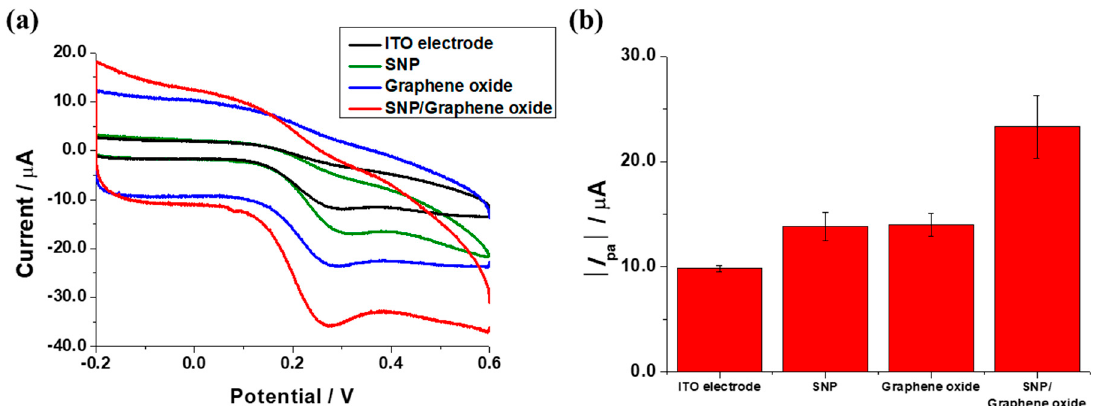
Figure 3. Electrochemical signal enhancement of the ITO electrode, SNP modified electrode, ITO electrode covered by graphene oxide and SNP modified electrode covered by graphene oxide with the addition of a 50 µ M dopamine solution using ( a ) CV measurements and ( b ) comparison of the absolute I pa values.